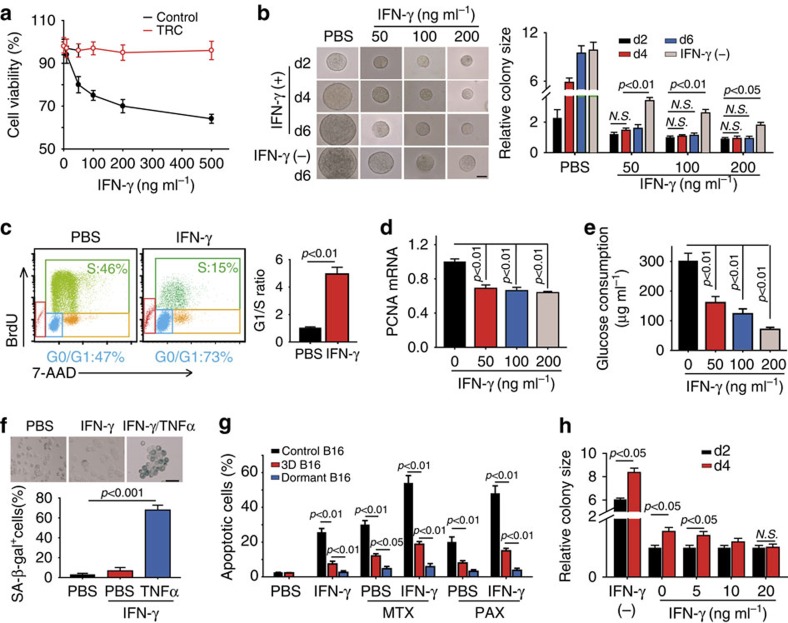
IFN-γ induces TRC dormancy in vitro.(a) B16 cells in conventional rigid plate or B16 TRCs seeded in soft 3D fibrin gels were cultured for 3 days in the presence of different concentration of IFN-γ. Cell viability were analysed by flow cytometry. (b,c) B16 cells were seeded in soft 3D fibrin gels for 3 days, and then treated with different doses of IFN-γ for additional 2 days (d2), 4 days (d4) or 6 days (d6). For the bottom wells, IFN-γ was provided for the first 4 days and withdrawn for the last 2 days. Colony size was indicated (b), and cell cycle was analysed after 3 days IFN-γ treatment (100 ng ml−1) (c). The relative colony size was calculated by comparing the colony size in other groups with the colony size in the group of IFN-γ (50 ng ml−1) treated for 2 days, which was set to 1. Bar, 50 μm. (d,e) IFN-γ treatment decreased the expression of PCNA mRNA in B16 TRCs (d), and the glucose consumption (e). (f) B16 TRCs were treated with IFN-γ (100 ng ml−1) or IFN-γ/TNF-α (10 ng ml−1) for 72 h. SA-β gal staining was conducted. Bar, 50 μm. (g) control B16 cells from rigid plate, B16 TRCs, or dormant TRCs (72 h IFN-γ treatment) were treated with methotrexate (MTX, 250 ng ml−1) or paclitaxal (PAX, 2 μg ml−1) for 24 h. Cell viability was measured by flow cytometry. (h) TRC dormancy induced by high dose of IFN-γ was maintained by low dose of IFN-γ. B16 TRCs were treated with 200 ng ml−1 IFN-γ for 2 days, then treated with different low doses of IFN-γ as indicated and cultured for another 2–4 days. The relative colony size was calculated by comparing the colony size in other groups with the colony size in the group of IFN-γ (0 ng ml−1) treated for 2 days, which was set to 1. Data shown are representative of three independent experiments and error bars represent mean±s.e.m., NS, no significant difference (Student's t-test).